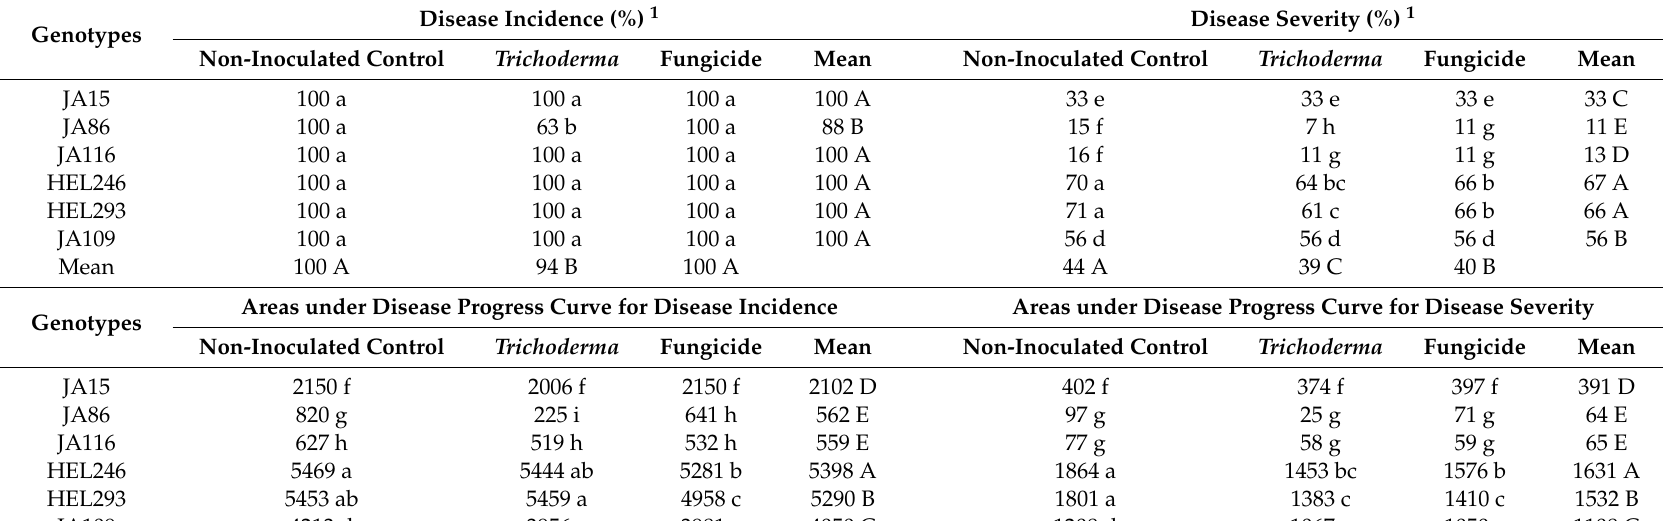
Table 2. Means of disease parameters under high- fertilization regime of six Jerusalem artichoke genotypes and three control